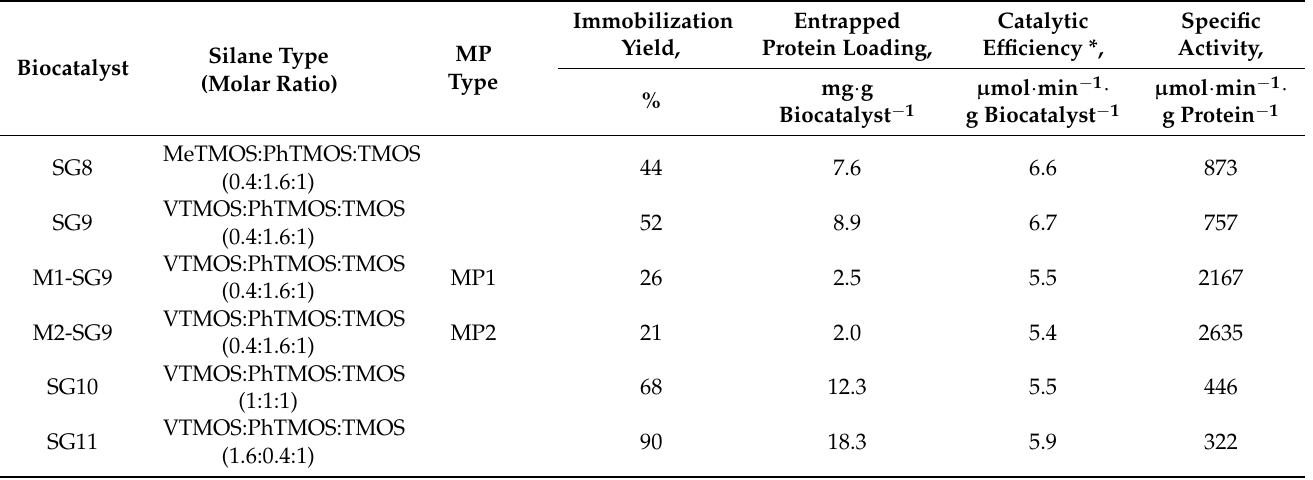
Table 2. Influence of the ternary silica network on the immobilization yield and catalytic efficiency of immobilized biocatalysts by their entrapment in sol–gel and magnetic